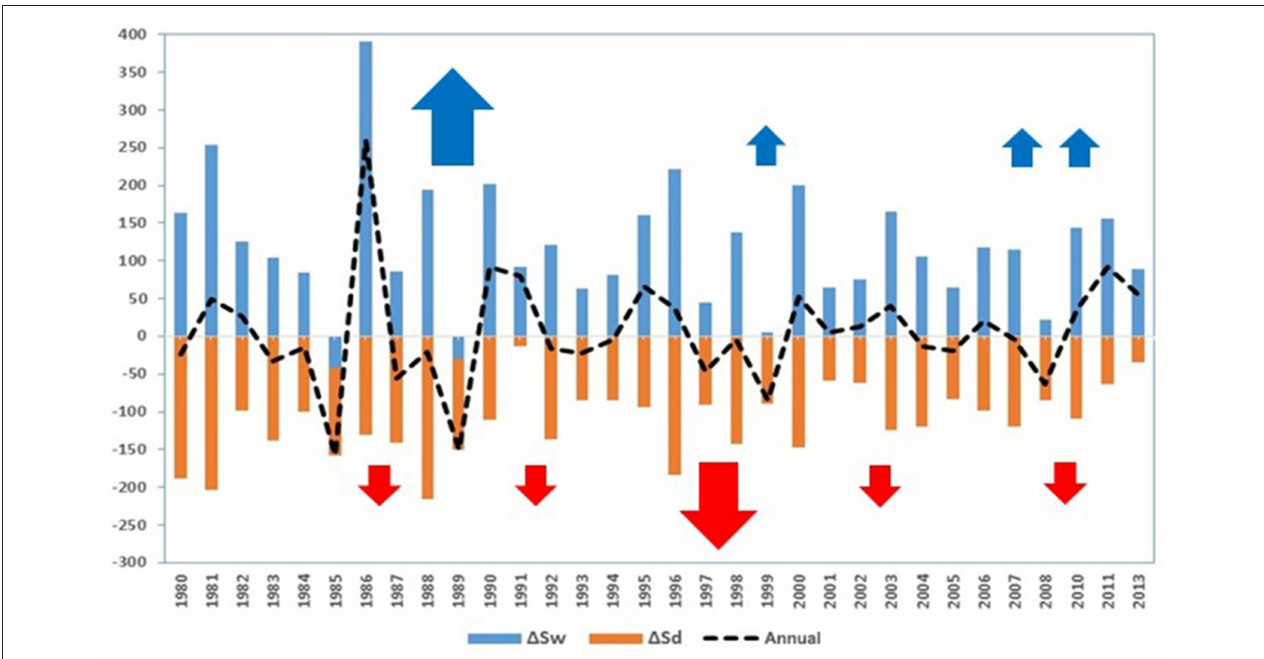
FIGURE 6 | Monthly variations in soil water storage for the wet ( 1 Sw) and dry months ( 1 Sd) in the IRW, in mm. The dashed line (black) represents the mean annual variation. Arrows: red = strong or moderate El Niño; blue = strong or moderate La